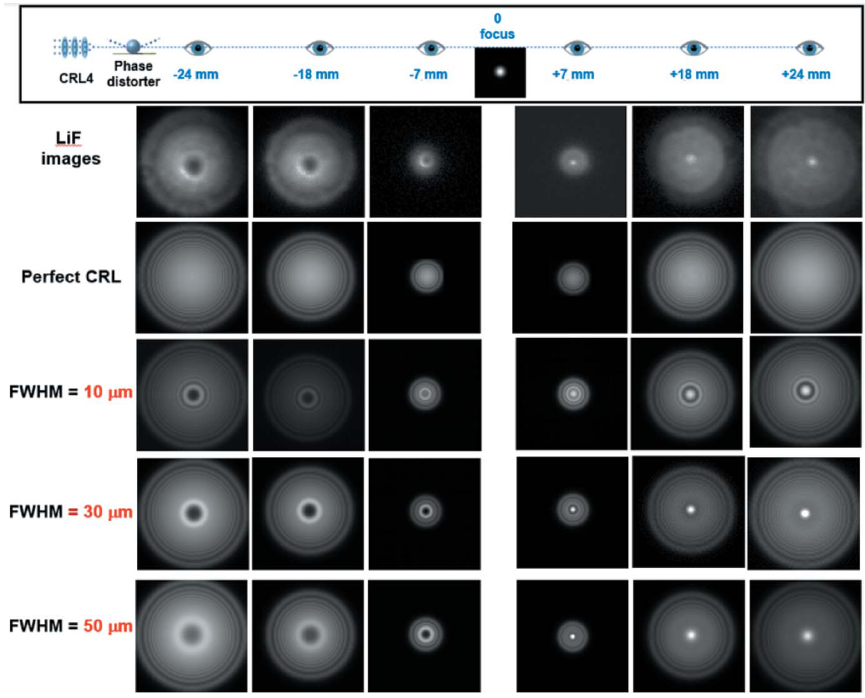
Figure 7 Influence of CRL4 shape imperfection on intensity distribution in the focused XFEL beam. Comparison of experimental observation (upper row of images) with simulations performed for different degrees of parabolic shape